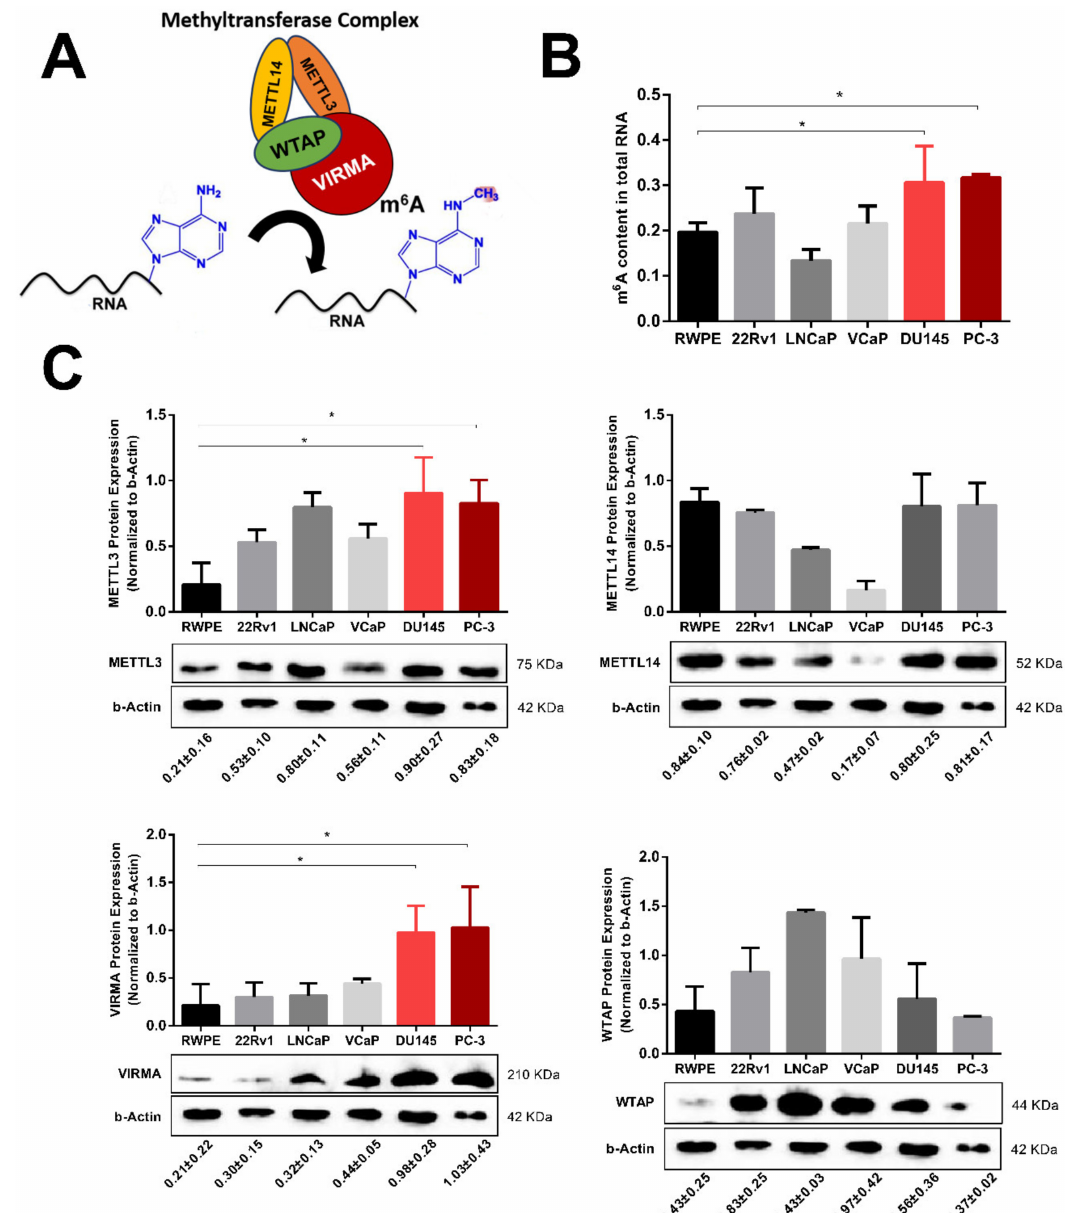
Figure 2. m 6 A RNA methylation is increased in androgen-independent prostate cancer cells. ( A ) Schematic illustration representing the methyltransferase complex (MTC) subunits that establish the m 6 A methylation mark; ( B ) m 6 A modification levels of total RNA assessed by ELISA in normal prostate basal epithelium cells (RWPE) and 5 di ff erent PCa cell lines (22RV1, LNCaP, VCaP, Du145, PC-3); ( C ) Western blot analysis showing the protein levels of each of the MTC subunits in the same cells. Shown is the relative protein abundance (normalized to β -actin). Data are shown as means ± SD and are representative of at least three independent experiments. * p < 0.05, Mann–Whitney U